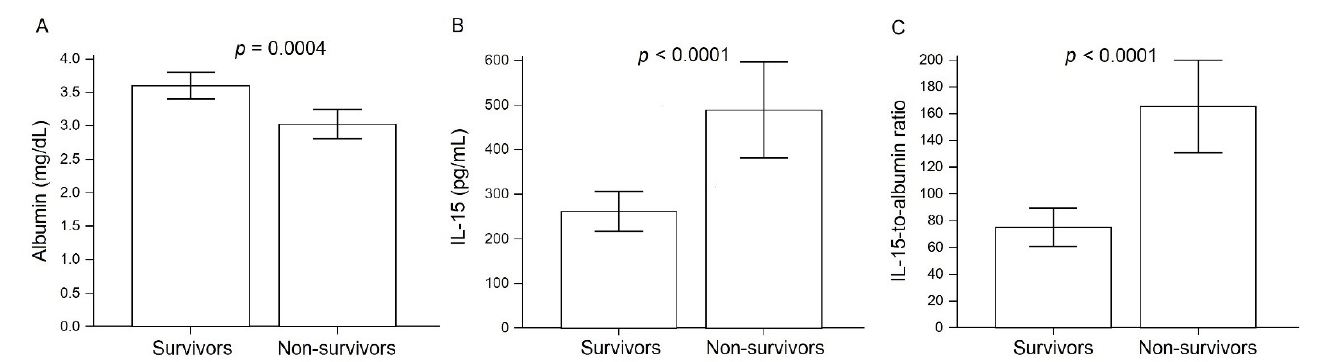
Figure 2. Serum levels of IL-15 and albumin in COVID-19 patients. ( A ) Serum albumin levels in survivors and non-survivors. ( B ) Serum IL-15 levels in survivors and non-survivors. ( C ) The IL-15-to-albumin ratio in survivors and non-survivors. The IL-15-to-albumin ratio resulted from dividing IL-15 serum values by serum albumin. Data are presented as mean ± standard deviation. We considered a p value < 0.05 as significant.